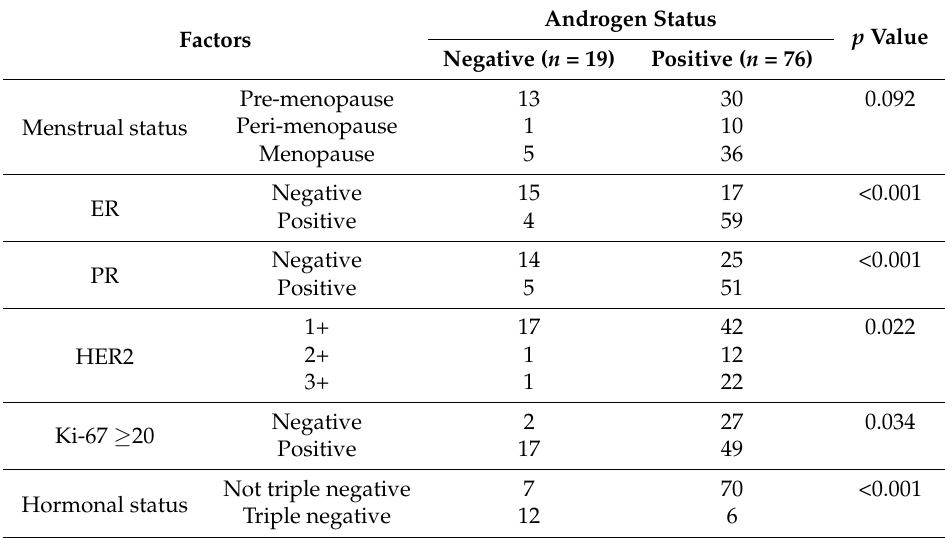
Table 1. Univariate analysis of factors related to androgen receptor (AR)